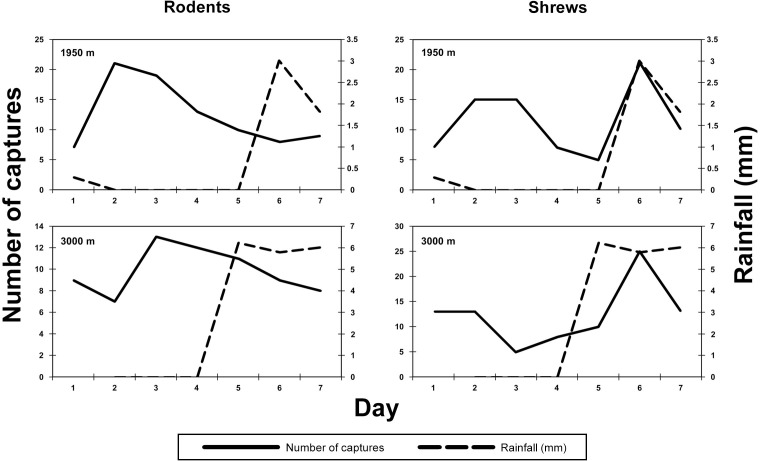
The relationship between numbers of individuals of small mammals captured each day of the sampling period, and rainfall, at each site on Mt. Meru.Rodentia are on the left and Soricomorpha are on the right.